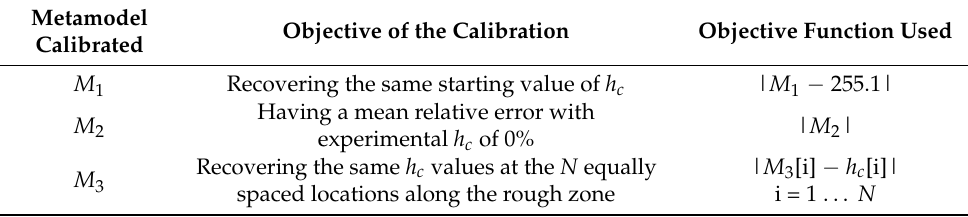
Table 4. Objective functions for calibration with the genetic